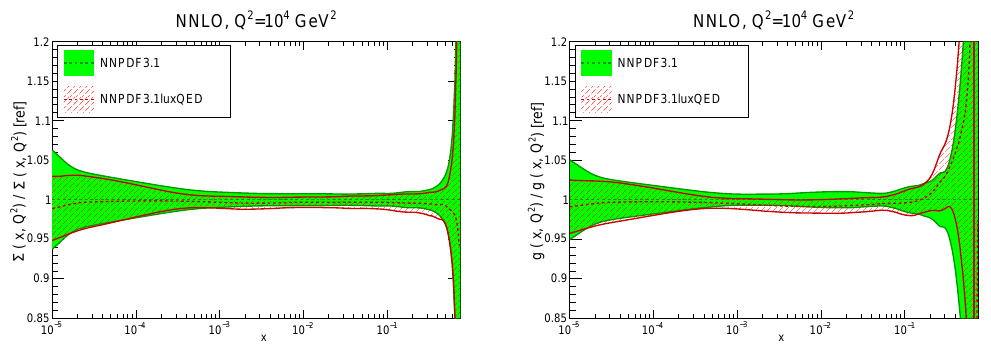
Figure 3.5: Comparison of the total quark singlet (left) and gluon PDFs (right) between NNPDF3.1 and NNPDF3.1luxQED at Q = 100 GeV, normalised to the central value of the former.